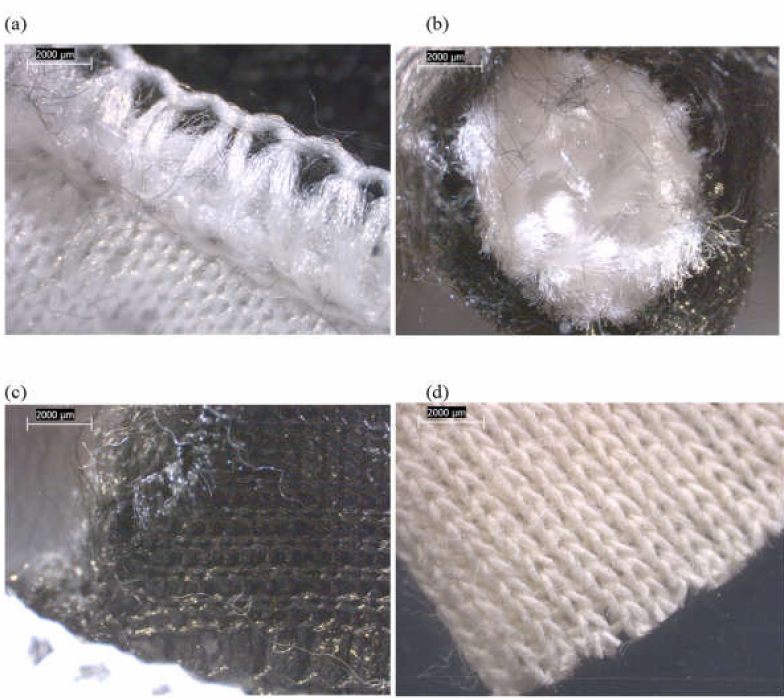
Figure 3. Low-power reflected-light stereozoom microscope images of FG-2 mattress subsamples acquired at 10 × . ( a – c ) Three sections of the synthetic, woven outer cover materials, including fiber-filled bead ( b ). ( d ) Inner cover material with natural, woven fibers.